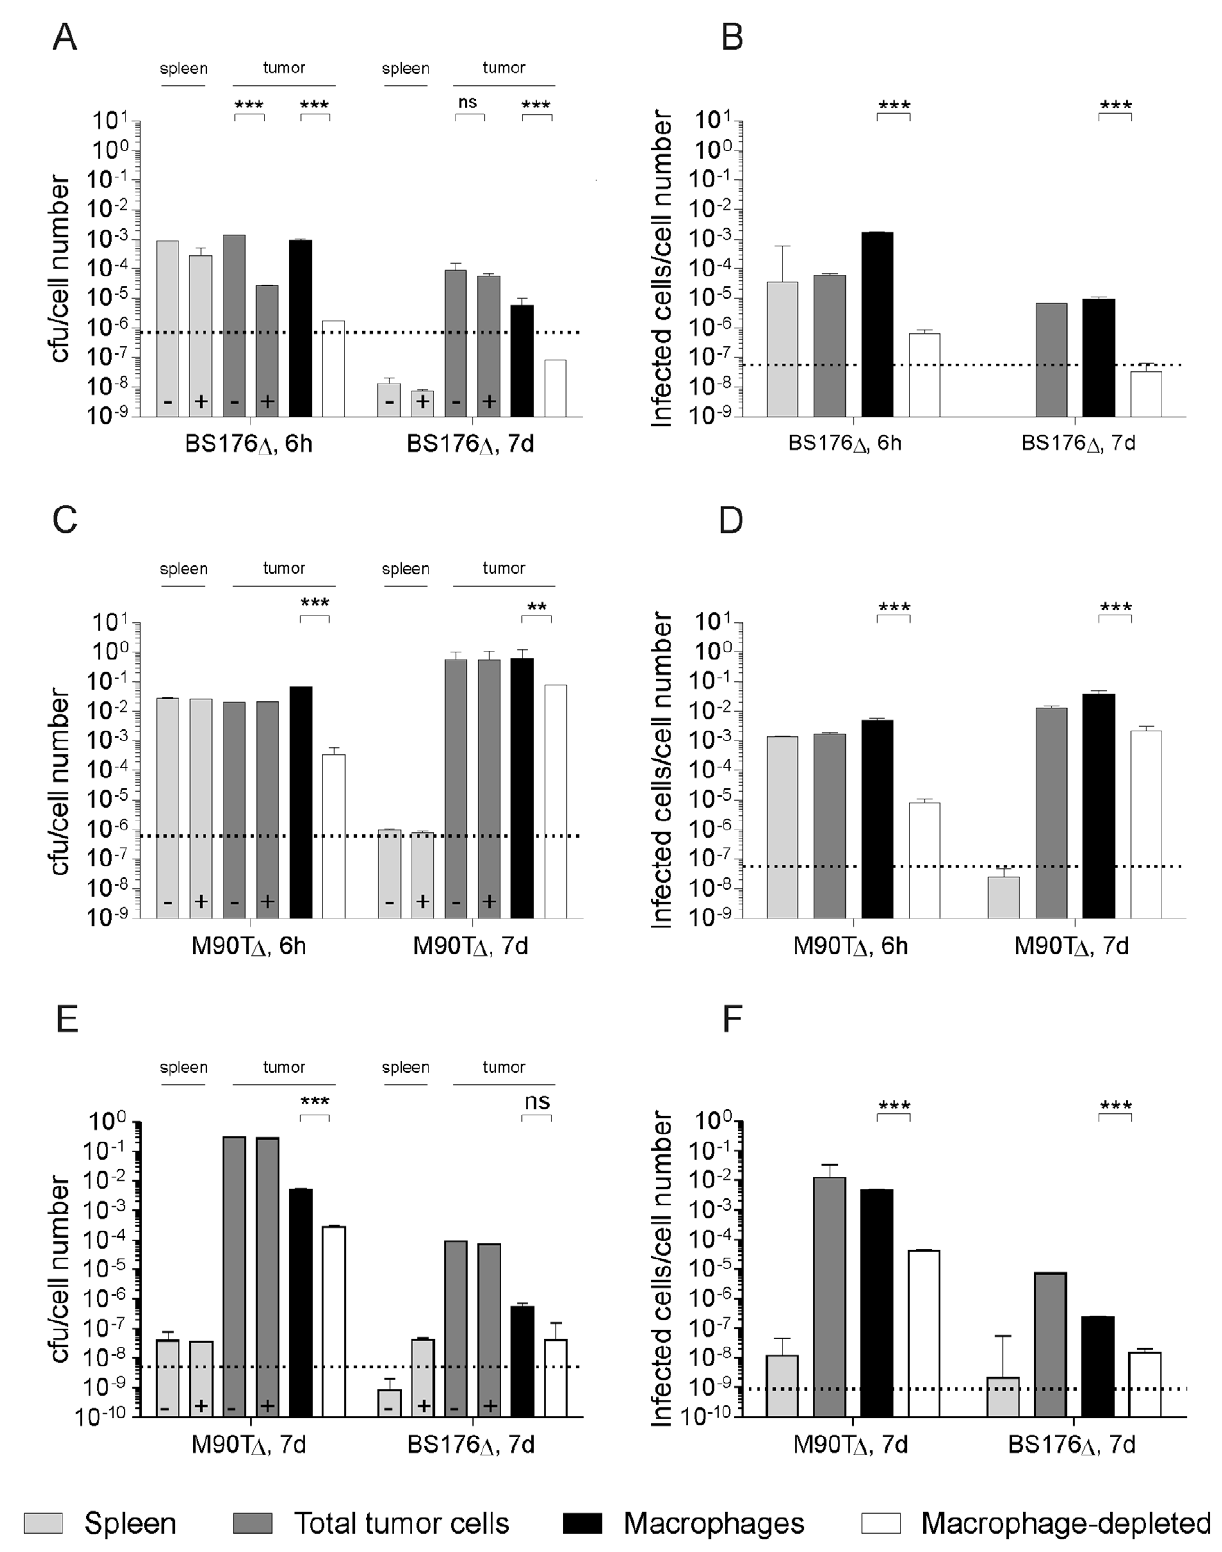
Figure 2. Shigellaflexneri M90T D aroA predominantly targeted TAMs invivo . Determination of CFU/cell number (A, C, E) and infected cells/ cell number (B, D, F) of separated tumor cells and spleen cells 6 h and 7d after i.v. infection with 1 6 10 6 bacteria of tumor-bearing 4T1 (A–D) and transgenic MMTV-HER2/neu mice (E, F). Corresponding raw data of CFU and infected cell counts are shown in Supporting Information S1: Fig. S6 and Supporting Information S1: Fig. S7. + indicates gentamicin treatment. Dashed lines indicate detection limits. All results shown are mean 6 SD of values from three mice per experiment; ** P , 0.01, *** P , 0.001. BS176 D : Shigella flexneri BS176 D aroA ; M90T D : Shigella flexneri M90T D aroA